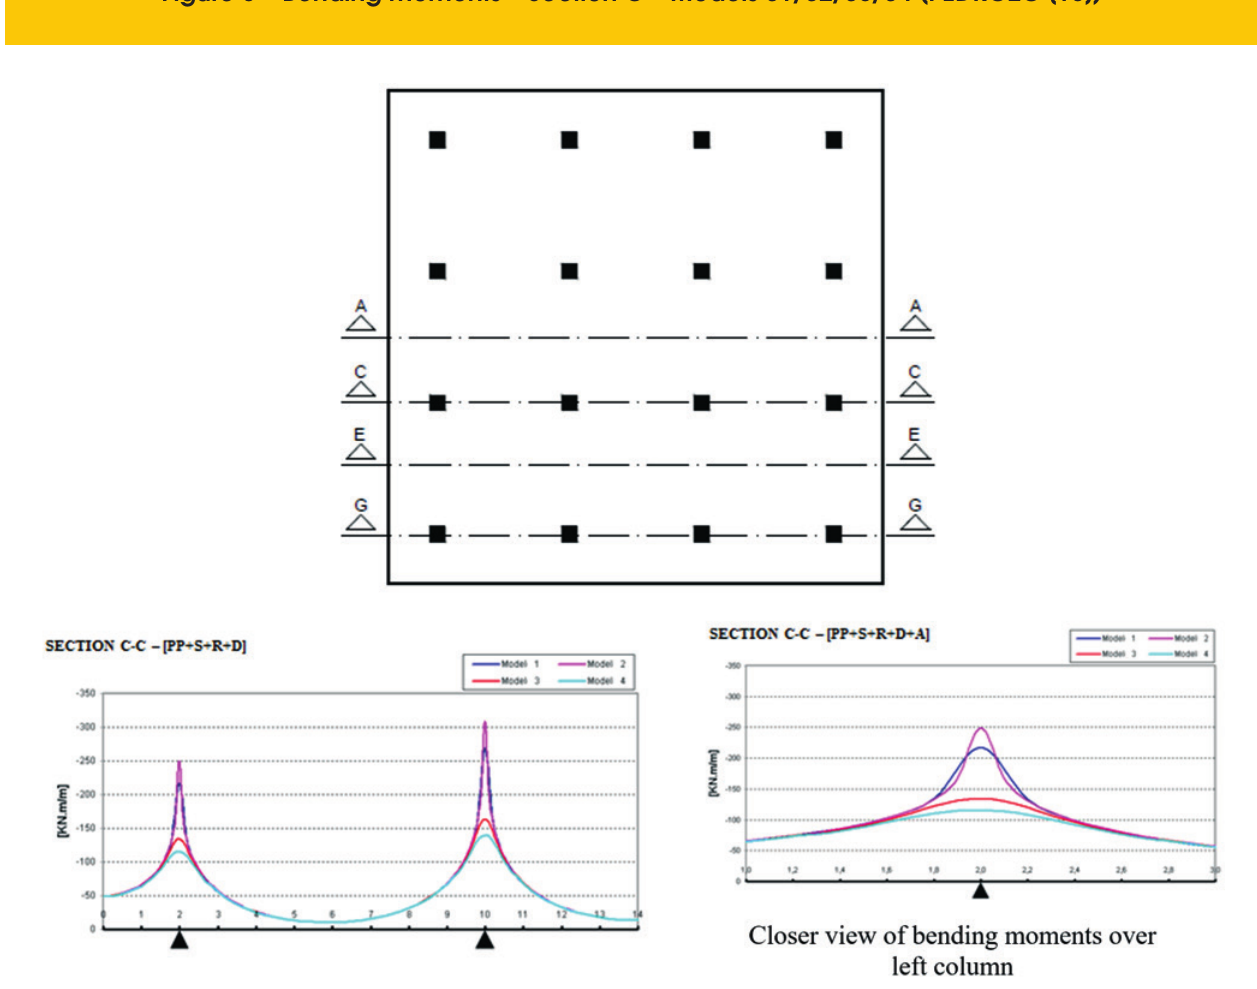
Figure 6 – Bending moments – Section C – Models 01/02/03/04 (PEDROZO